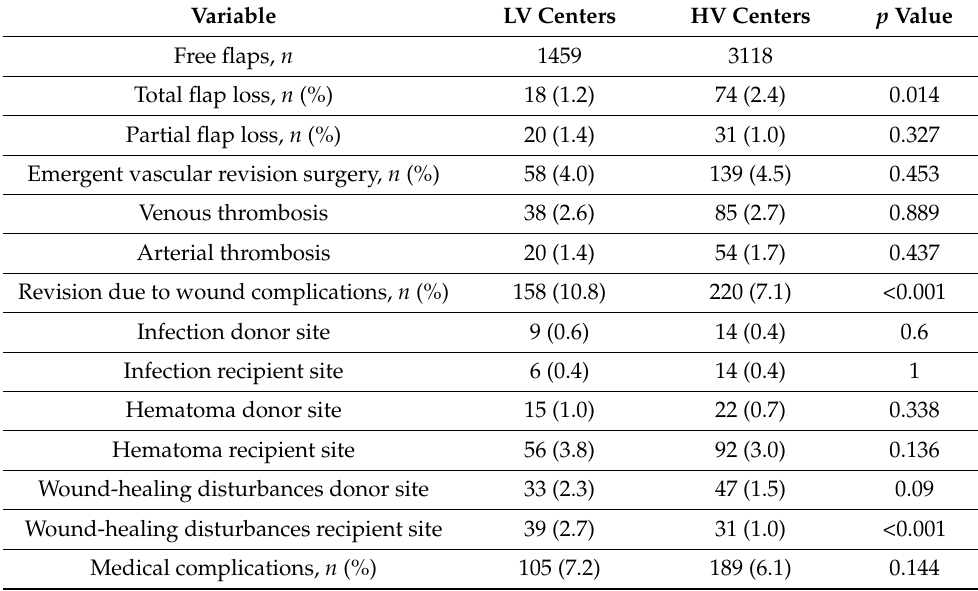
Table 6. Postoperative complications according to the average number of DIEP flaps performed per year per center (high-volume group: ≥ Ø 40 DIEP flaps per year of data entry vs. low-volume group < Ø 40 DIEP flaps per year of data